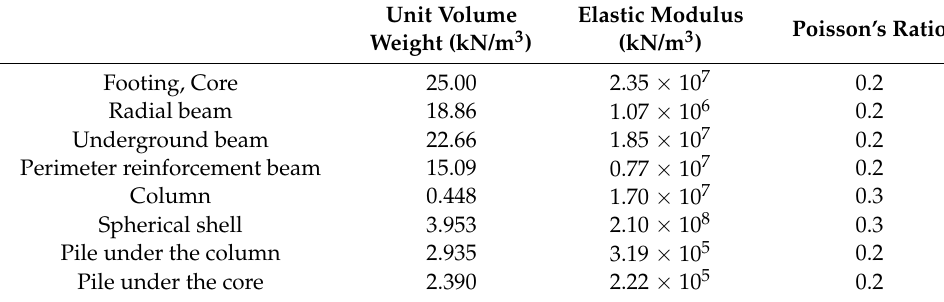
Figure 7. Analysis model.